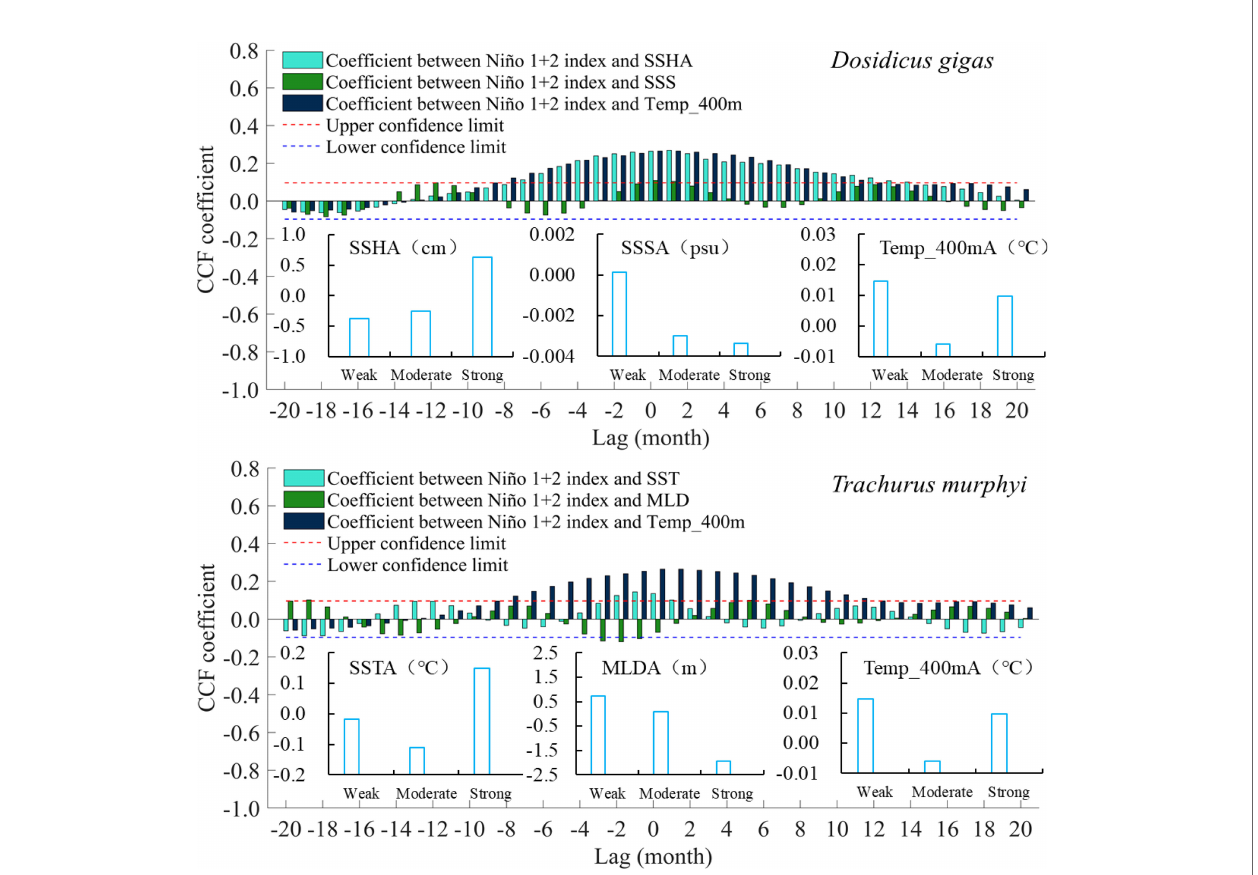
FIGURE 2 | Cross-correlation coef fi cient between the Niño 1 + 2 index and environmental factors and variation of anomaly value of environmental factors under El Niño events with different intensities.